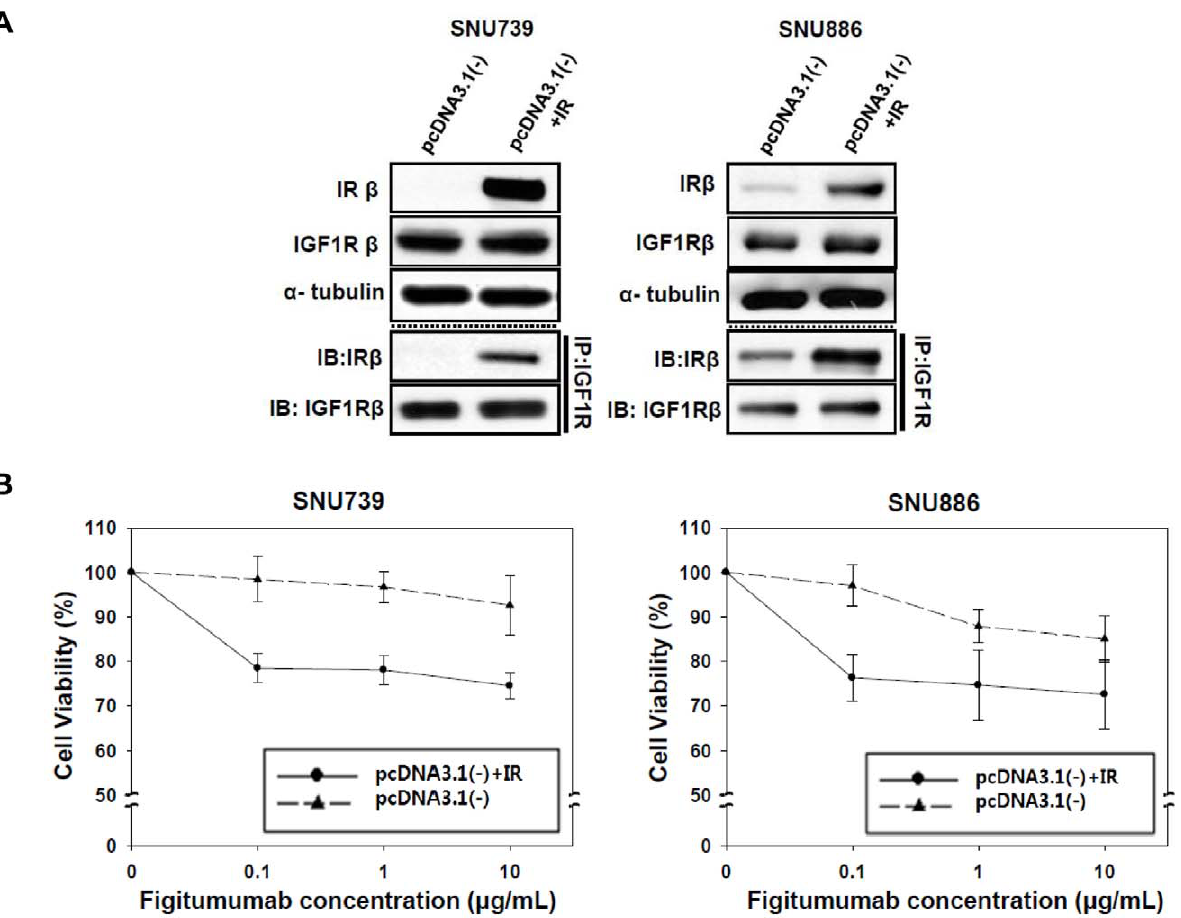
Figure 3. Effect of selective IR overexpression on HR levels and the anti-proliferative effect of figitumumab in IR-transfected cells. A) Effect of IR transfection on IGF1R/IR HR levels in IR-negative cell lines. Cells were transfected with the pcDNA3.1(-) expression vector containing wild-type IR cDNA. An equal amount of lysates from cells transfected with either the empty vector or pcDNA3.1(-) containing IR cDNA was subjected to immunoprecipitation with an anti-IGF1R antibody followed by Western blot analyses of IR b and IGF1R b . B) Effect of IR-transfection on figitumumab sensitivity. Transfected cells were plated onto 96-well plates, treated with figitumumab for 5 d, and subjected to MTT assays. Solid triangle symbol with dashed lines=empty vector (pcDNA3.1-), Solid circle symbols with lines=pcDNA3.1(-) IR. Bar= 6 SE. Mean values were derived from six replicates. Experiments were repeated in triplicate.